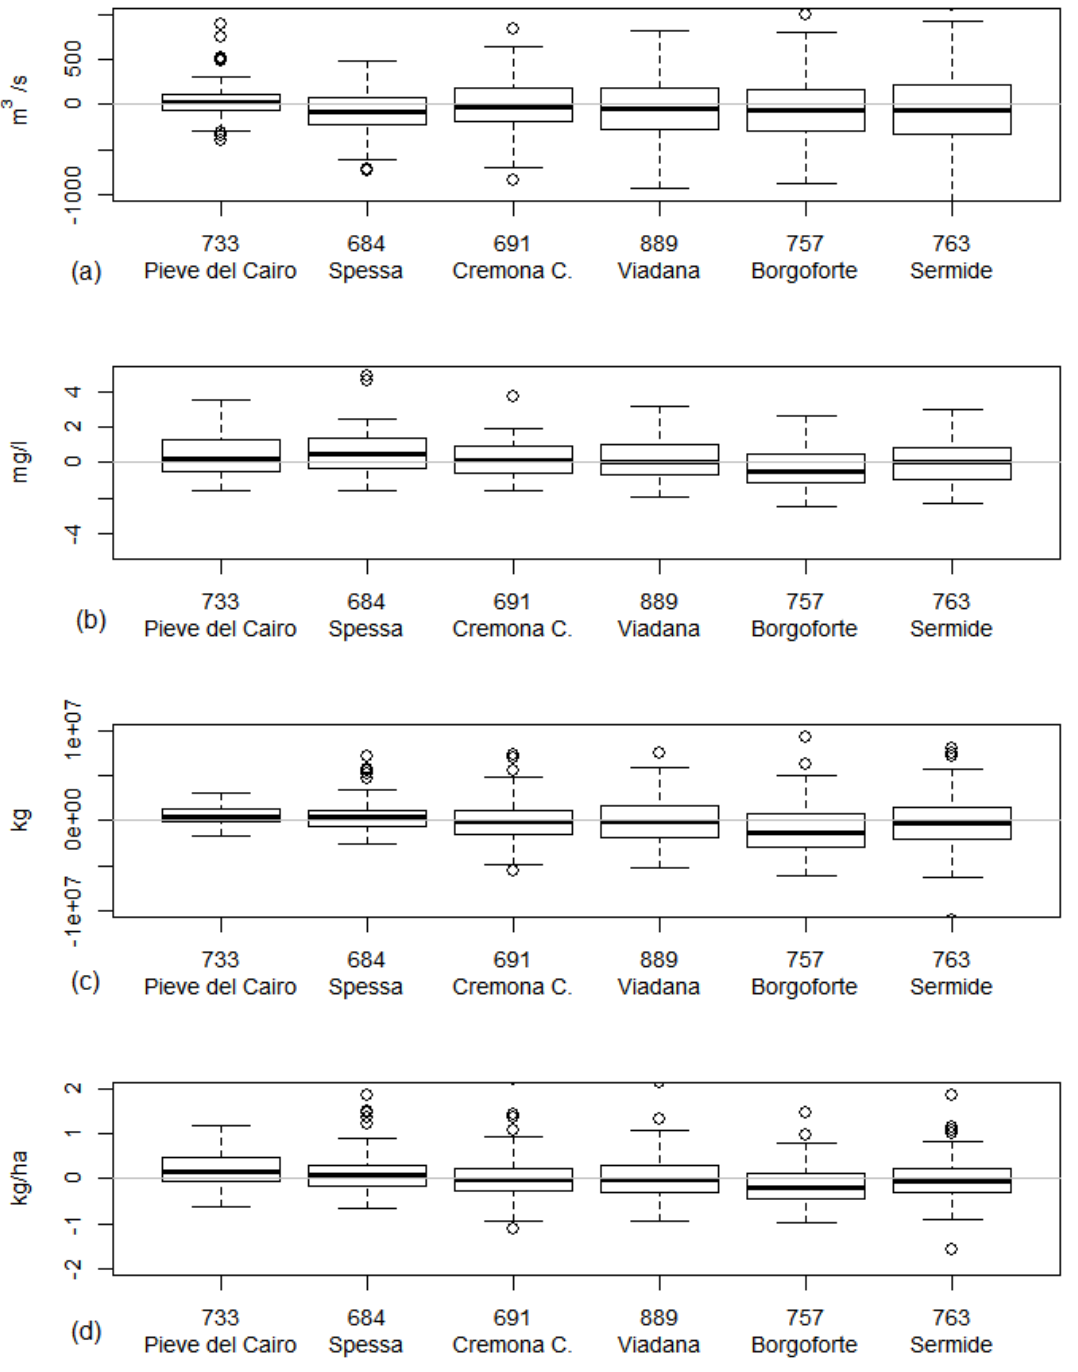
Figure 5. Box plots of residuals (simulation-observation) of monthly streamflow ( a ), N-NO 3 concentrations ( b ), loads ( c ) and specific loads ( d ) along 6 stations from source to mouth (left to right) of the Po River.